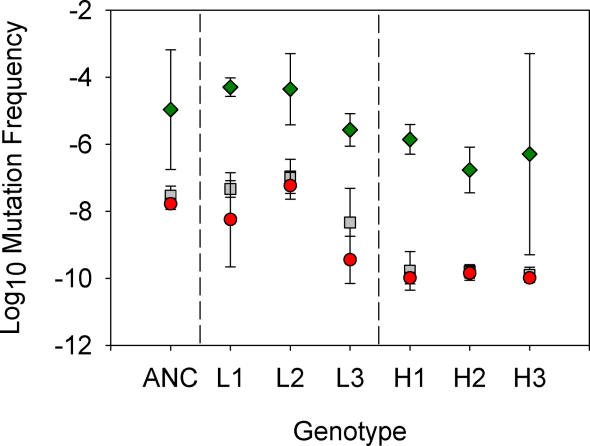
Differences in Virus Robustness Are Not Confounded by Increased Mutation Frequencies in Viruses Evolved under High Co-InfectionMean mutation frequency (± 95% confidence interval) was assayed for wild-type φ6 (ANC), and for one pre-bottleneck clone isolated from each population evolved under low co-infection (L1–L3) and high co-infection (H1–H3). Assays on P. tomato (circles) and P. atrofaciens (squares) were replicated 5-fold. Assays for P. atrofaciens mutants challenged with growth on P. tomato (diamonds) were replicated 6-fold, except for H3 (n = 2).